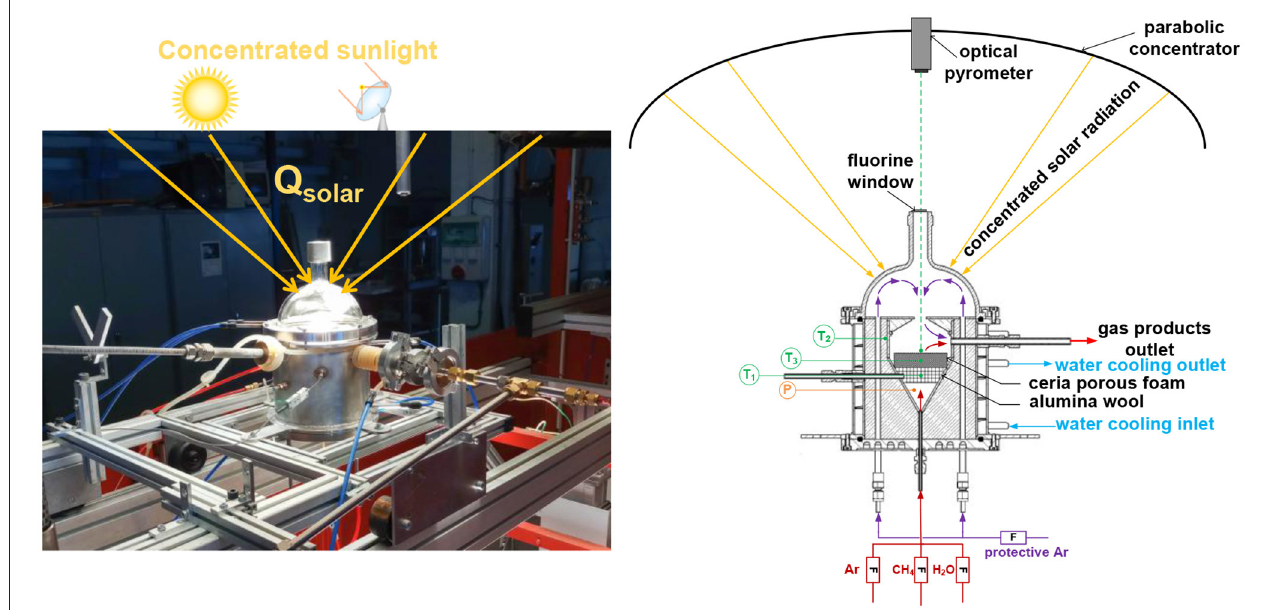
FIGURE 2 | Photograph (left) and schematic illustration (right) of the 1.5-kW th prototype solar reactor driven by real high-flux solar radiation for methane reforming and H 2 O splitting over the ceria redox